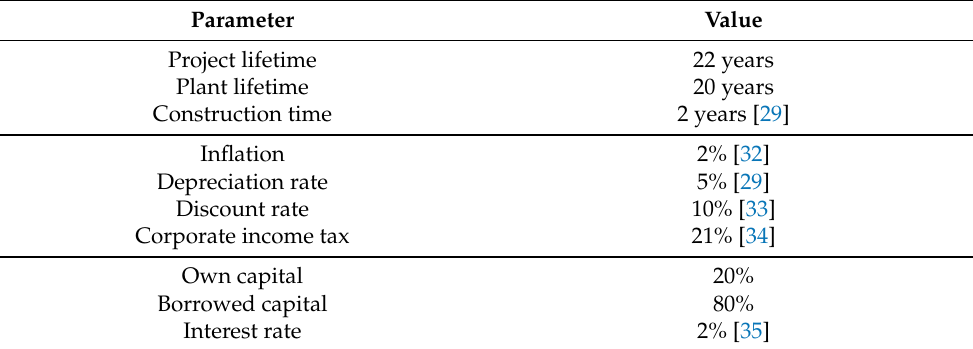
Table 4. Parameters used in the economic